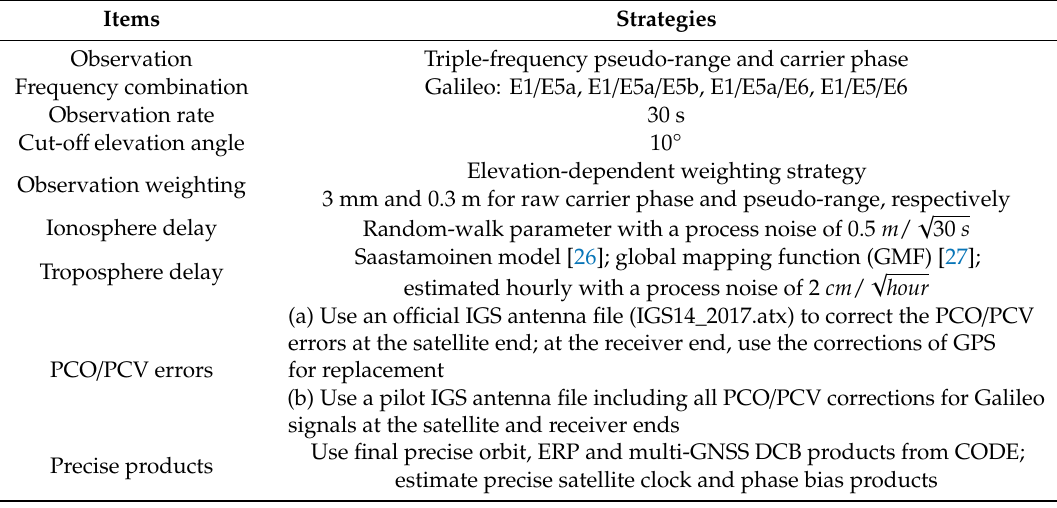
Table 2. Data processing strategies of